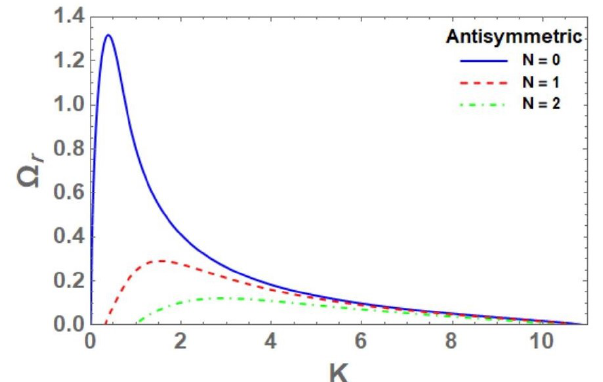
Figure 2. Variation in the non-dimensional growth rate Ω r with different values of the non- dimensional wave number K the two- and three-dimensional of configuration N = 0 and N = 1,2, respectively, when We = 1000; Oh = 0.1; ρ = 0.01; v = 0.2; κ 1 = 2; ˜ (cid:101) l = 0.3; ˜ (cid:101) g = 0.1; E = 3; U = 1.5; V (cid:48) = 0.1; ε = 0.5, for axisymmetric disturbance case.